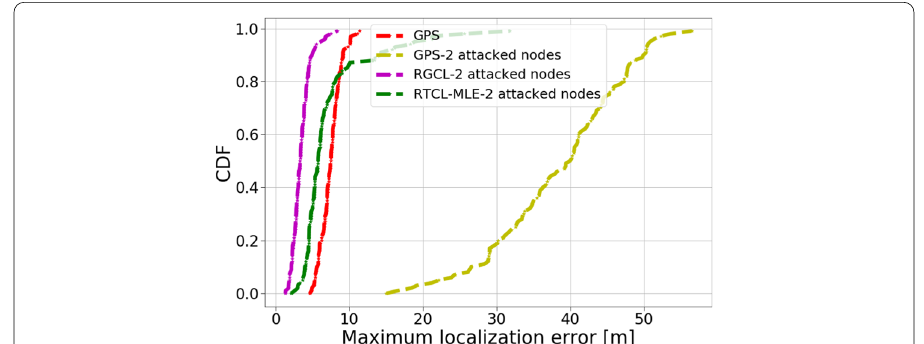
Fig. 11 CDFs for maximum localization error with 2 vehicles under GPS location spoofing attack